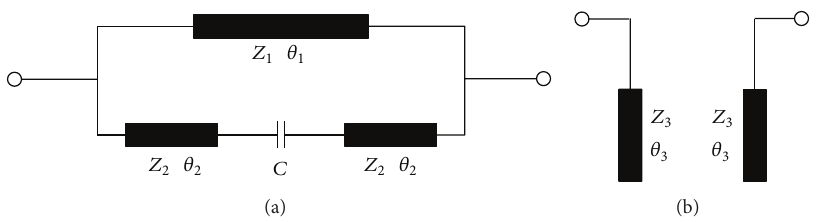
Figure 2: (a) Capacitor-embedded transmission line ring. (b) Two symmetrical open-circuited transmission lines.